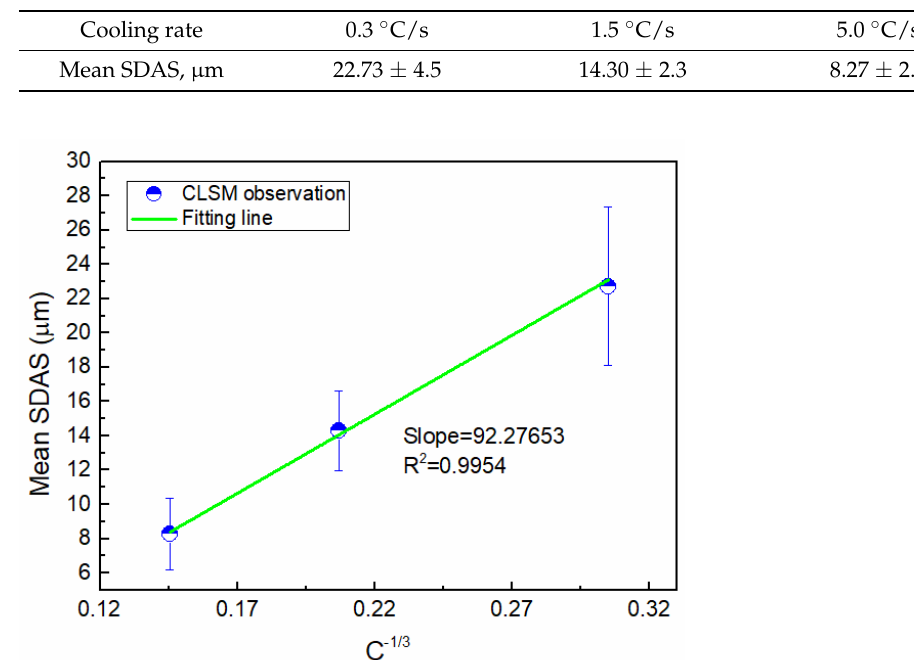
Table 1. Mean values of SDAS measured in different cooling rate samples.